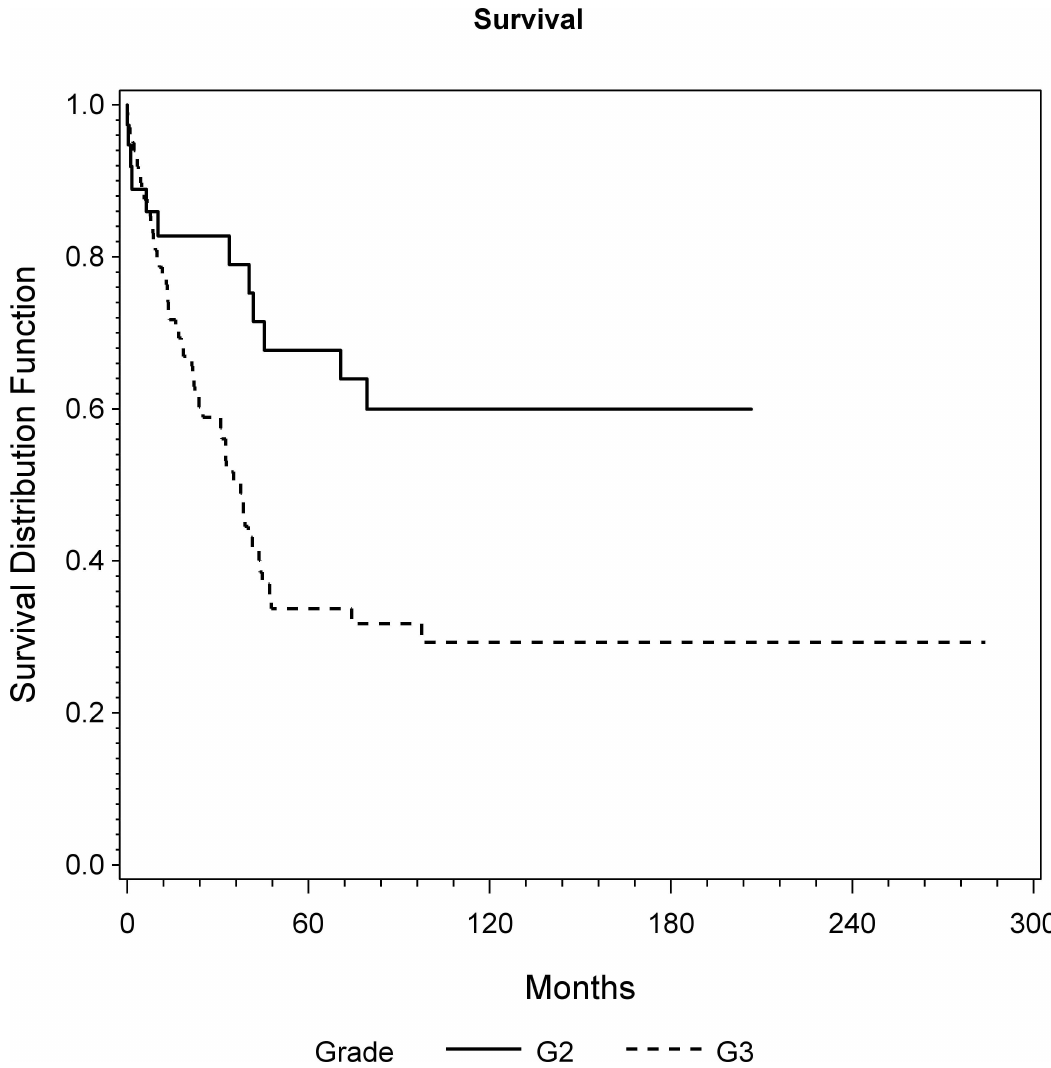
Fig 2. Overall survival of patients with grade 2 and grade 3 as assessedby KM analysis (p = 0.005; HR = 3.04).